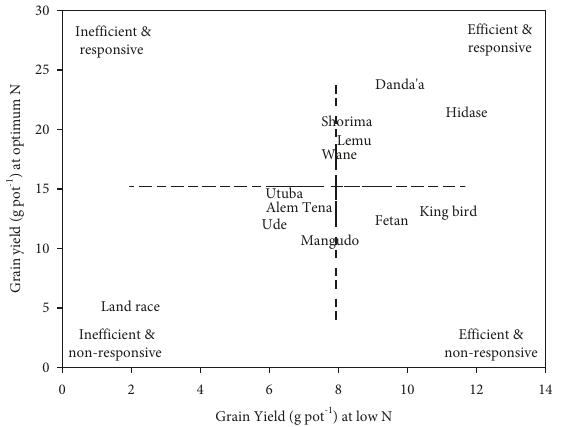
Figure 6: Categorization of wheat cultivars to N-efficiency and N- responsive groups using grain yield. Vertical and horizontal broken lines show average grain yield under low N and optimum N,